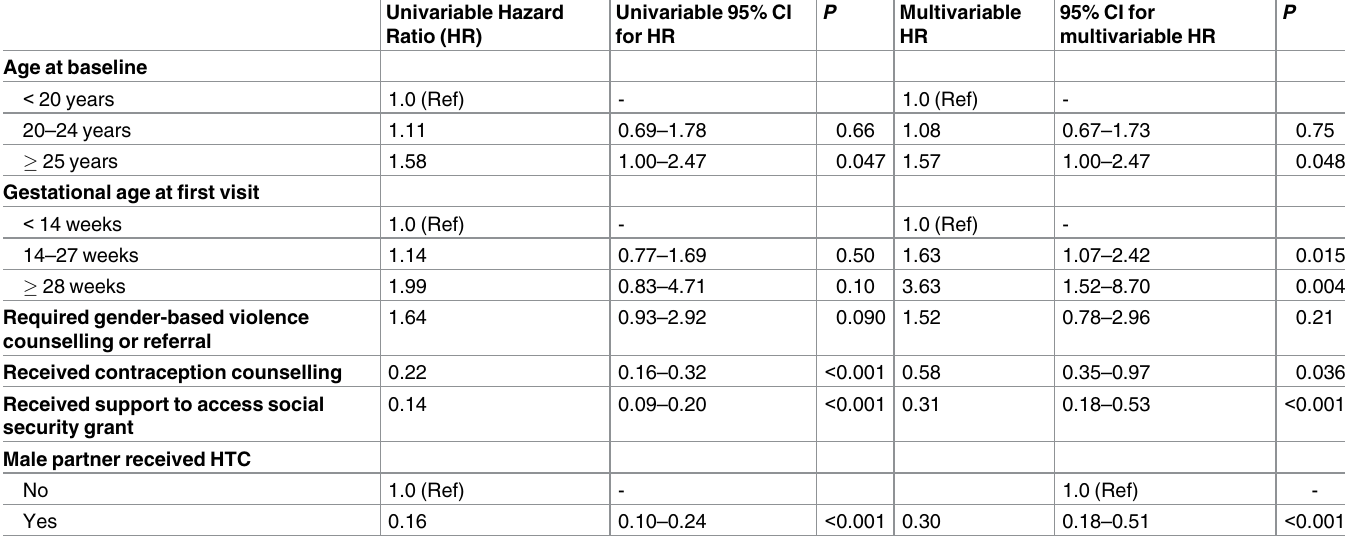
Table 4. Factors associated with loss to follow-up amongst pregnant and postpartum women enrolled in a combination HIV prevention interven- tion in South